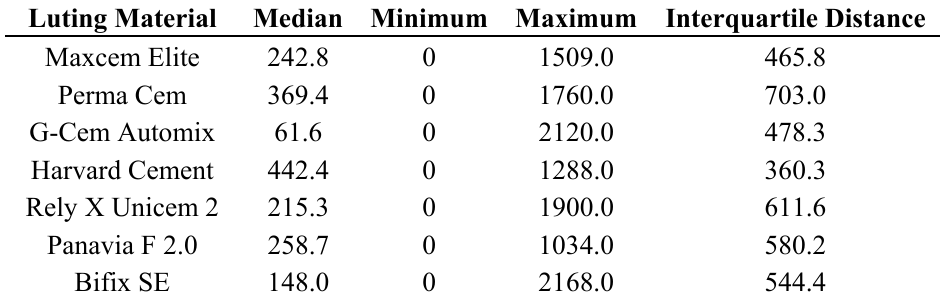
Table 6. Descriptive data of the statistical evaluation of microleakage in dentin in μ